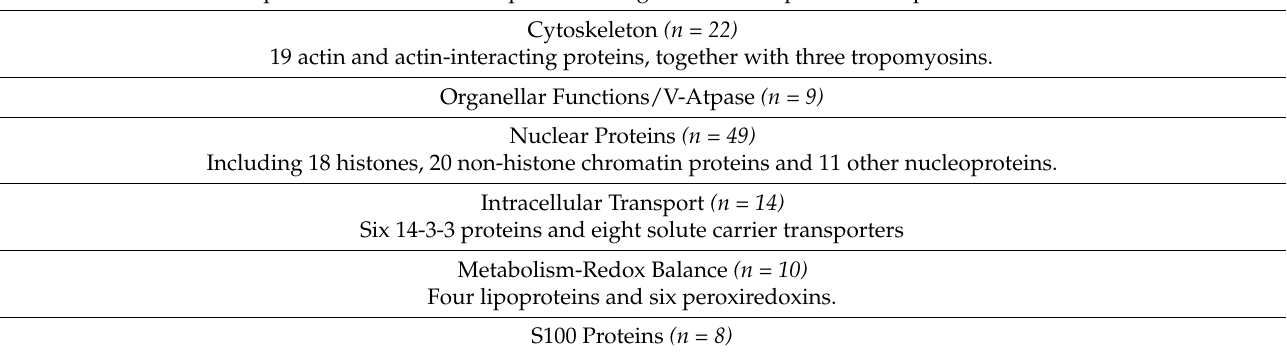
Table 2. Cont. Protein Synthesis, Stabilization and Modulation (n = 156) Including five RNA binding proteins, 12 proteins involved in splicing, 44 ribosomal proteins, 21 proteins involved in translation initiation and elongation. In addition to these proteins: Chaperons: Seven T complex proteins, 17 heat shock proteins and six Peptidyl-prolyl cis-trans isomerases. Posttranscriptional modulation: four proteins involved in glycosylation, eight proteins involved in protein phosphorylation, 12 proteins involved in ubiquitination together with 20 proteasomal